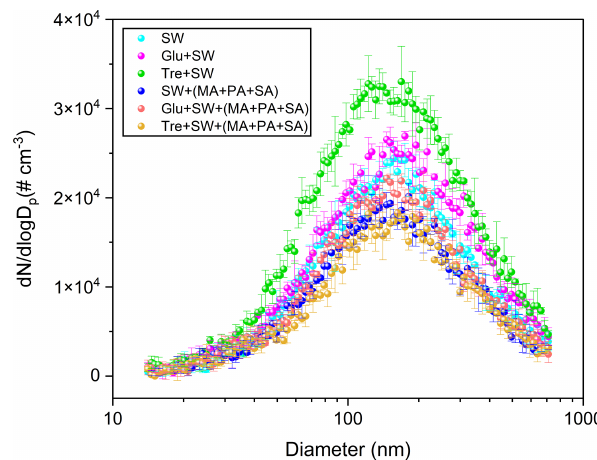
Figure 2. The particle number size distribution spectra of SSAs produced from a blank seawater sample and a seawater sample spiked with glucose or trehalose. Both results are presented here with and without fatty acid surface